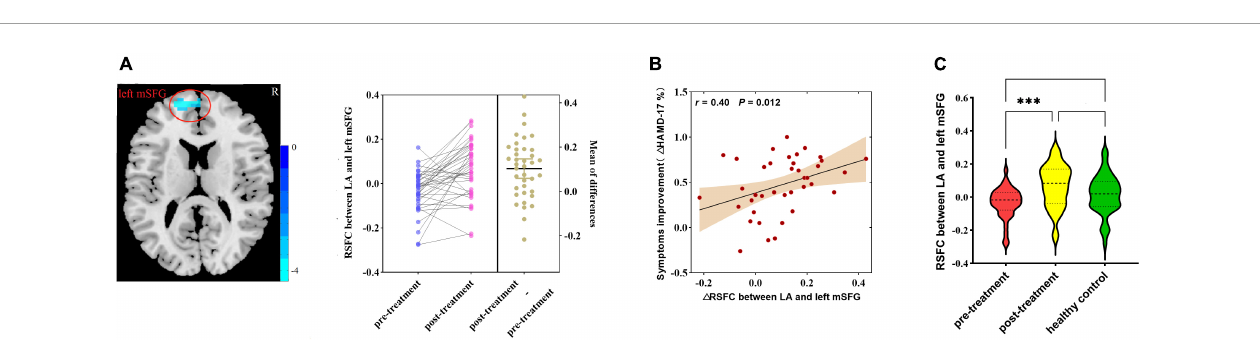
FIGURE3 (A) Differences in RSFC between pre-treatment and post-treatment MDD patients (paired samples t -test, voxel-level p < 0.001, corrected by FWE; left amygdala cluster size threshold k ≥ 40). Color bar represents t -values. (B) Correlation analysis of changes in RSFC of the amygdala with the rate of reduction in HAMD-17 in MDD patients after ketamine treatment. (C) Differences in RSFC among pre-treatment, post-treatment MDD patients, and HCs (analysis of variance). RSFC, resting-state functional connectivity; MDD, major depressive disorder; HAMD-17, 17-item of Hamilton Depression Rating Scale; LA, left amygdala; mSFG, medial superior frontal gyrus; (cid:49) HAMD-17%, HAMD-17 reduction rate. ∗∗∗ p <